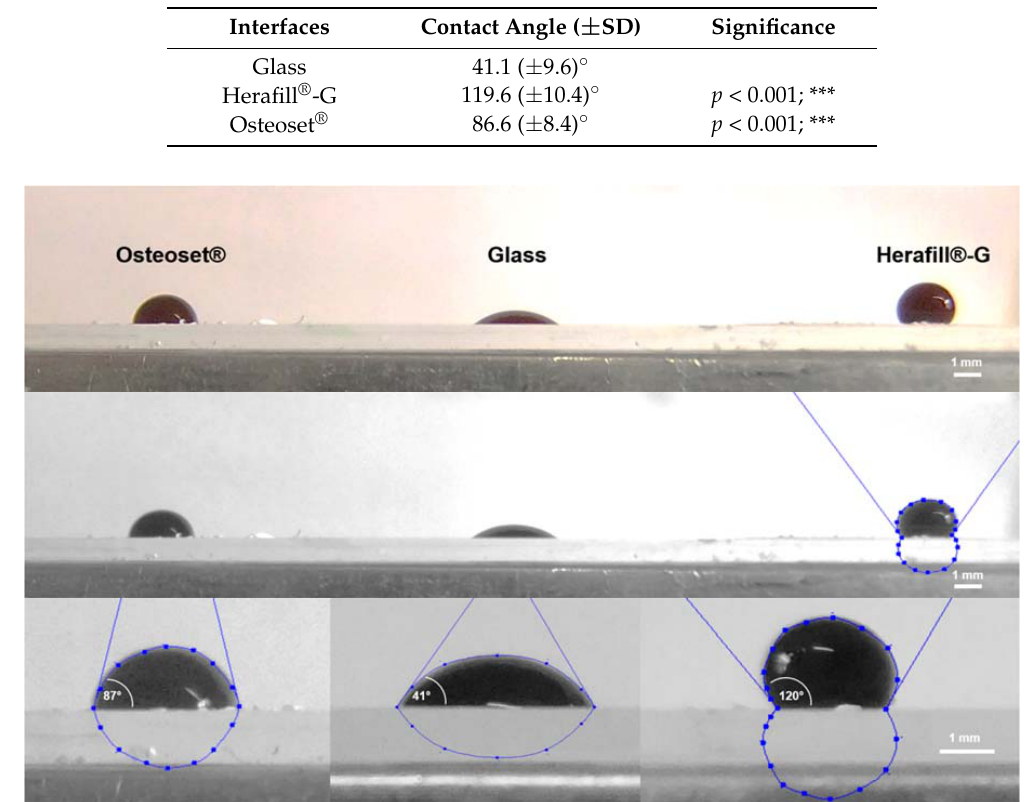
Figure 3 . Contact angle measurement in graphic comparison. Magnifications showing average contact angles of fresh human blood on test surfaces ( n = 8). White scale bar indicating 1 mm.